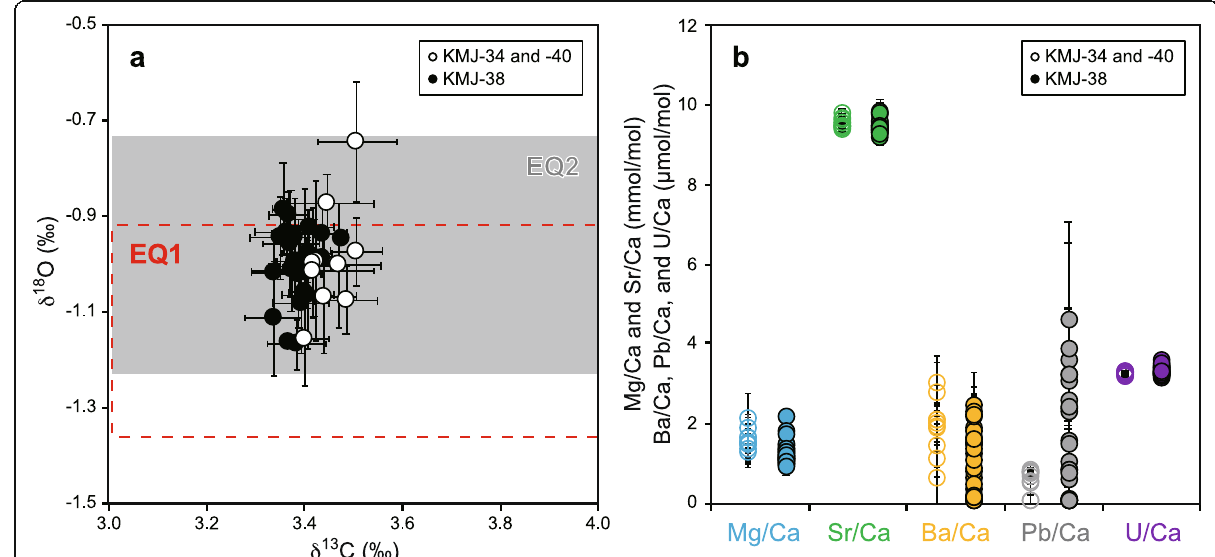
Fig. 8 Scatter plot of a δ 18 O and δ 13 C and b elements/Ca ratios of sclerosponges. Data are shown as averages with 1 σ standard deviations in individual samples, which show intraspecific variations in sclerosponge geochemistry. Red (EQ1) and gray (EQ2) areas are shown respectively as estimated ranges of isotopically equilibrium aragonite precipitated at the study site using a relation between seawater δ 18 O and salinity by Oba (1990) and Abe et al. (2009)